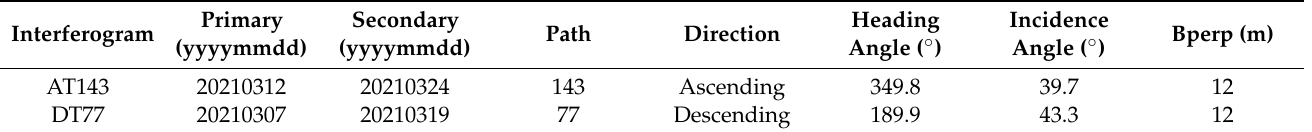
Table 2. Details of the coseismic Sentinel-1 SAR data used in this study. Bperp is the perpendicular